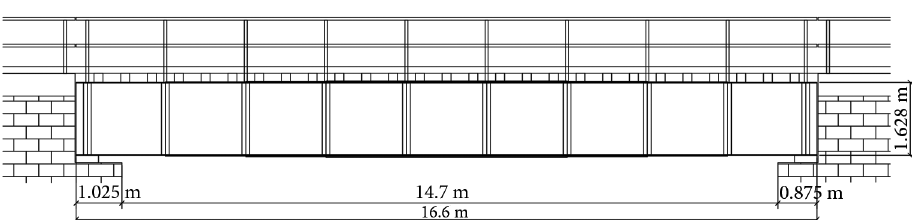
Fig. 3. A side view of the century-old railway steel bridge which operated on the Radom-Tomaszów Mazowiecki route in Poland